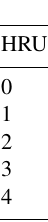
Table 2. Storage distribution in a hypothetical heterogeneous wa- tershed used to illustrate the variation of S W with P